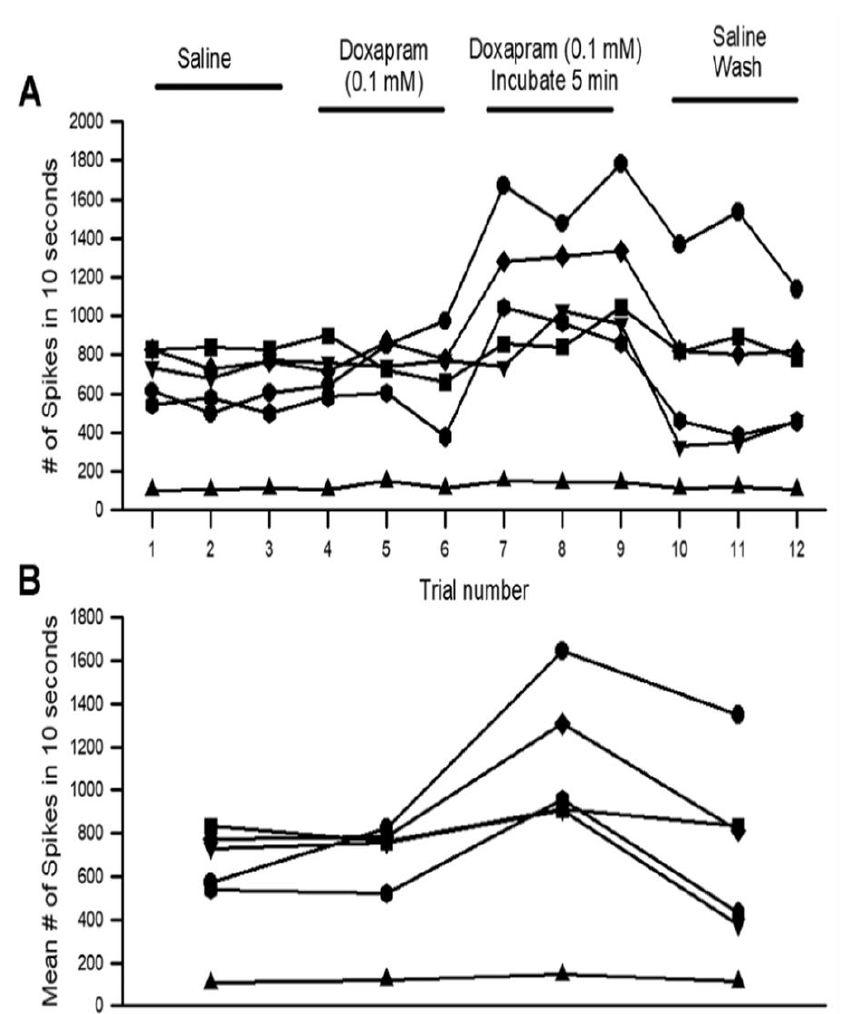
Figure 5. The acute effect of doxapram (0.1 mM) on neural activity of the PD organ. ( A ) The number of spikes measured in the 10 s window from the beginning movement of the joint starting from a bent position (90 degrees) to fully extended within 1 s and held in an extended position for the next 9 s. This paradigm is repeated three times for each condition. Each line represents a different preparation of a PD organ. Three trials were undertaken with saline, three trials were done immediately after switching the bath to doxapram (0.1 mM), and they were examined again after incubation for 5 min. The final exchange was to rinse the preparation twice with fresh saline and then move the joint three more times. Each movement was separated by at least 10 s while the joint was held in a bent position. ( B ) The number of spikes in each of the three trials was averaged and graphed in the same manner as in ( A ), which allows an easier view of the overall effects.